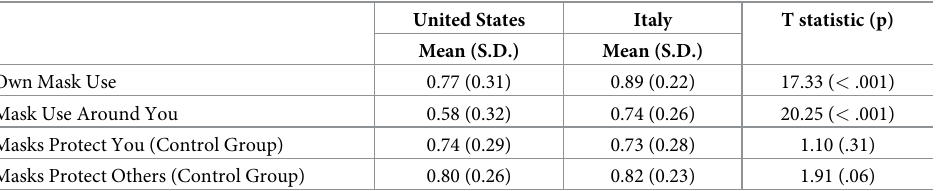
Table 2. Baseline mask use and